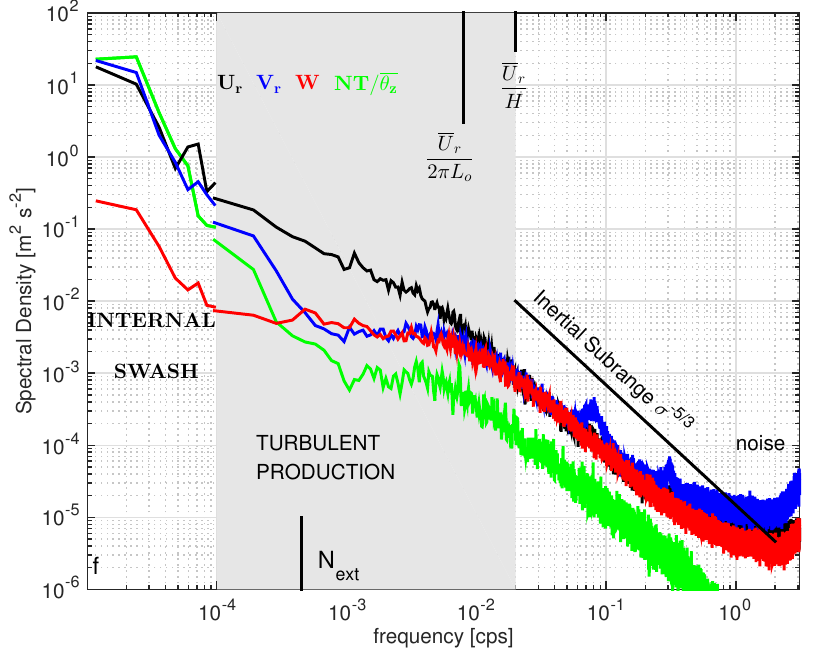
Figure 9. MAVS+RBR spectra over the 2.8 day record. Spectra use two windows. Temperature data have been interpolated onto the MAVS time base and are rendered as potential energy by multiplying the temperature time series by N / θ z . See Figure 10 for spectra of the original time series. The frequency scale corresponding to length scale limitations on the inertial subrange U The Ozmidov length L o is a a factor of two larger, indicating that the sensor is within a ‘boundary influenced’ [51] regime.